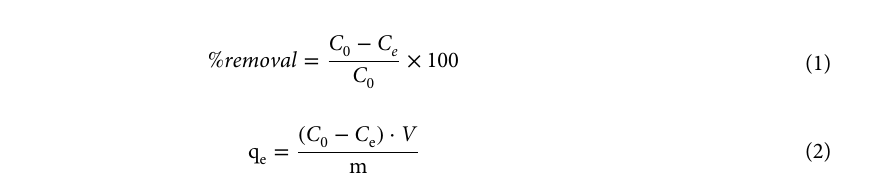
Figure 4. Effects of ( a ) the initial pH on the adsorption efficiency of Sb(III) (dosage = 400 mg/50 mL dry weight; Sb(III) concentration = 10 mg/L; temperature = 298 k; rotation speed = 150 rad/min; contact time = 240 min), ( b ) the GAD dose on adsorption efficiency of Sb(III) (pH = 6; Sb(III) concentration = 10 mg/L; temperature = 298 k; rotation speed = 150 rad/min; contact time = 240 min), ( c ) the NaCl concentration on adsorption efficiency of Sb(III) (pH = 6; dosage = 400 mg/50 mL dry weight; Sb(III) concentration = 10 mg/L; temperature = 298 k; rotation speed = 150 rad/min; contact time = 240